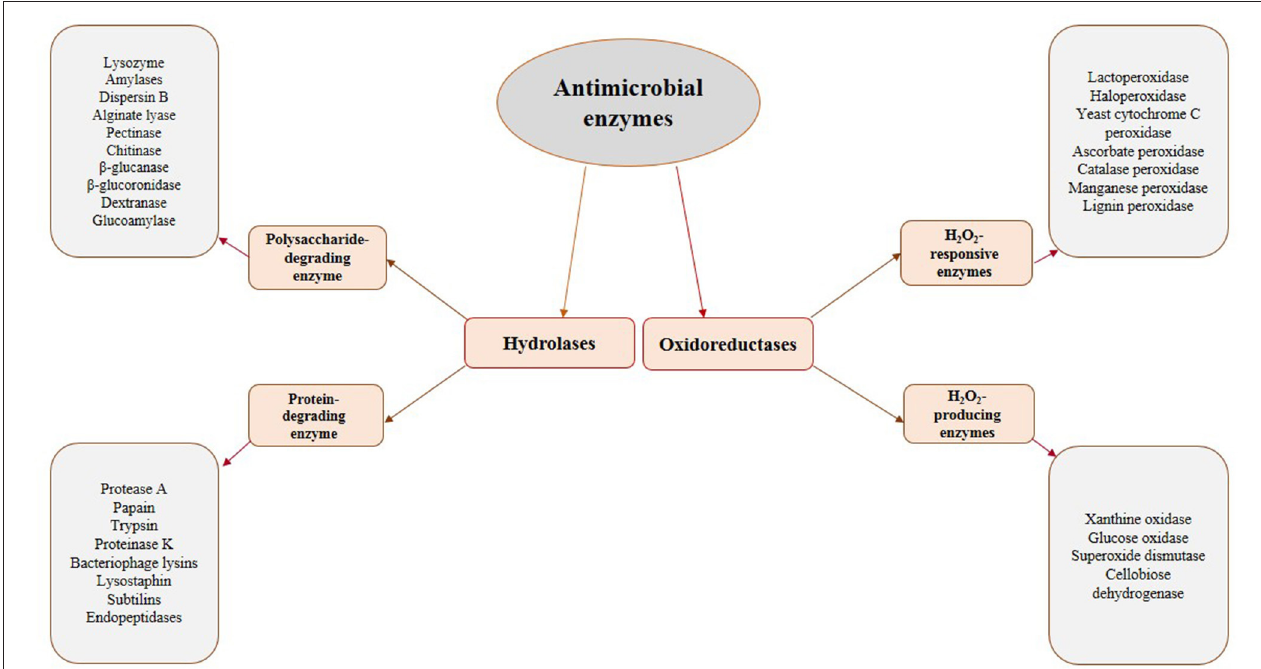
FIGURE 1 | The most promising antimicrobial